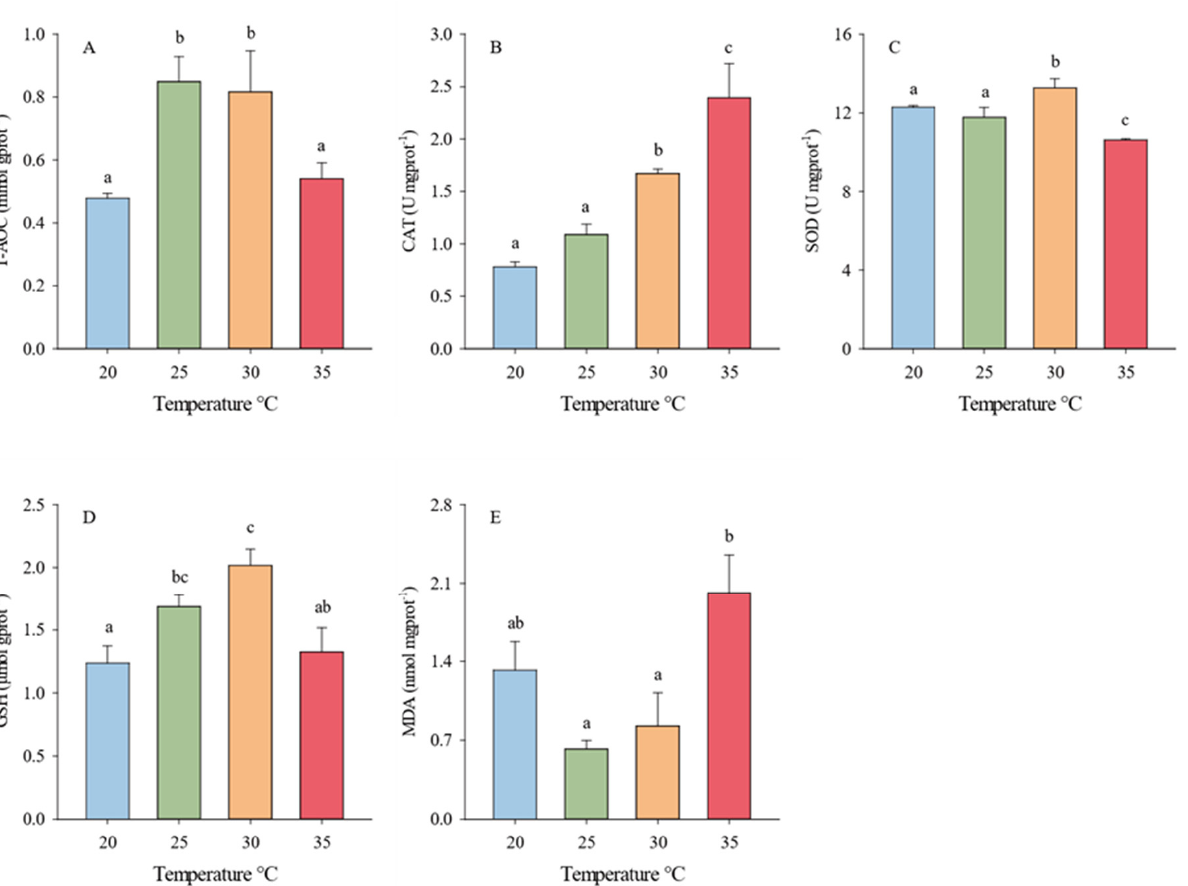
Figure 7. Effects of different temperatures on the activities total of antioxidant capacity (T-AOC) ( A ), catalase (CAT) ( B ), superoxide dismutase (SOD) ( C ), glutathione (GSH) ( D ), and malondialdehyde (MDA) ( E ) content of juvenile mud crabs. Values are expressed as mean ± SD ( n = 3). Different superscripts indicate significant differences between treatments ( p < 0.05).